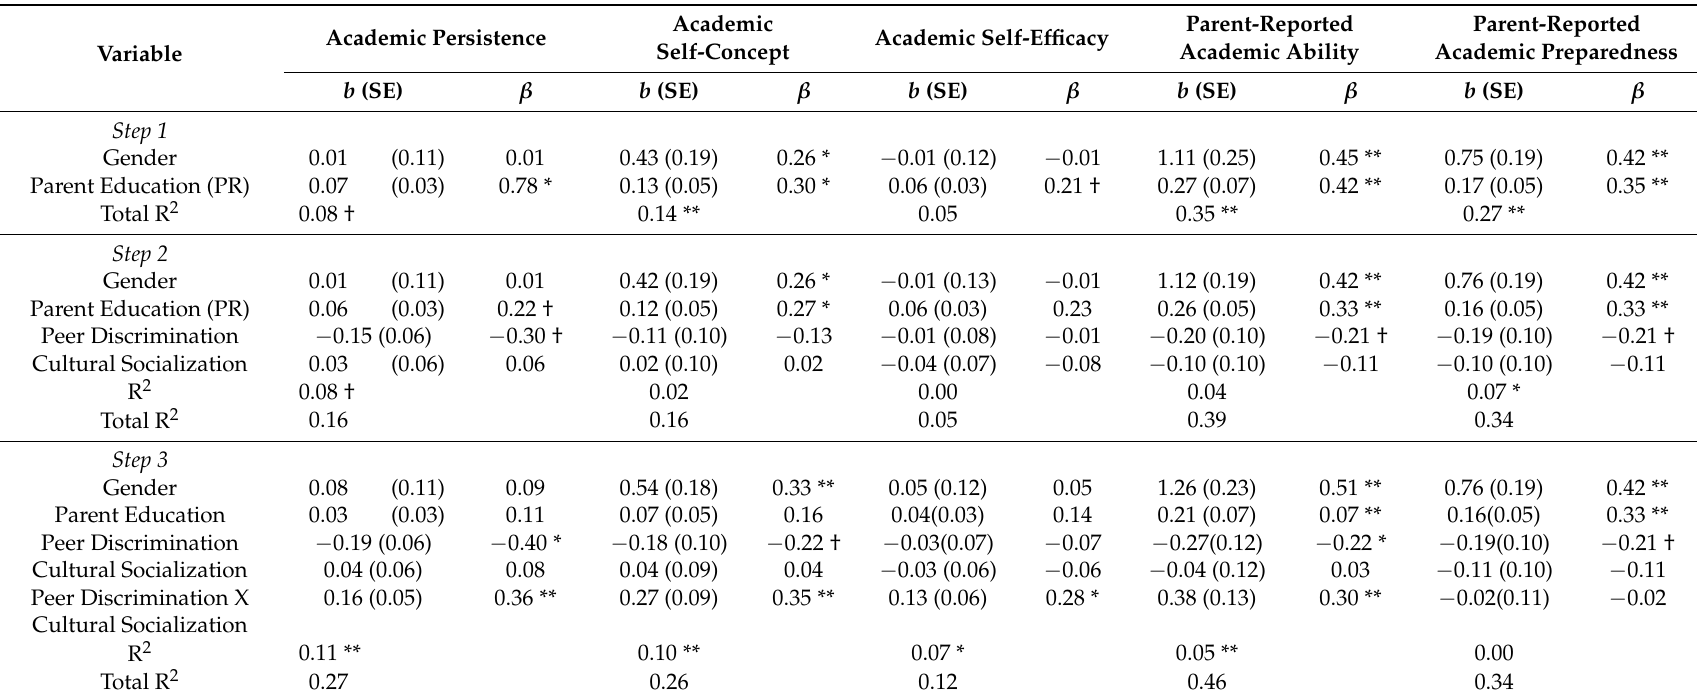
Table 3. Perceived Peer Discrimination by Cultural Socialization: Academic